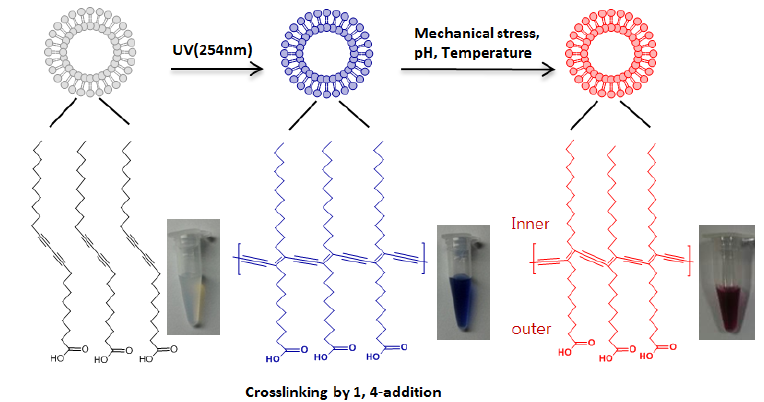
Figure 11. Chemical structure of polydiacetylene and its chromatic properties. ( a ) Polymerized backbone of vesicles. ( b ) blue-red color transitions (drawn with ChemDraw, PerkinElmer,